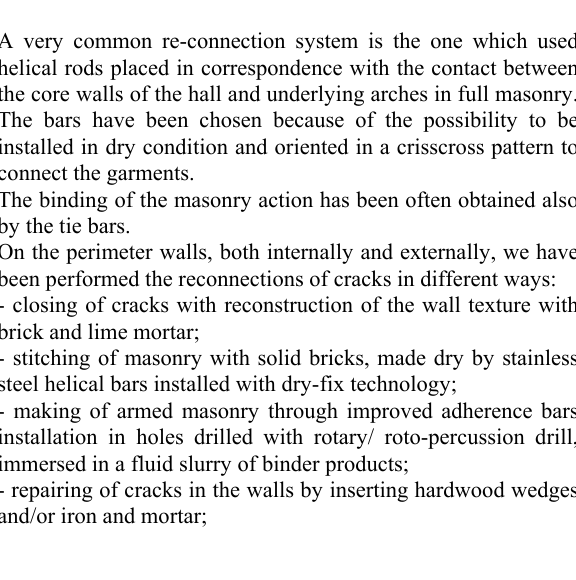
Figure 6: example of hooking of the façade wall to the